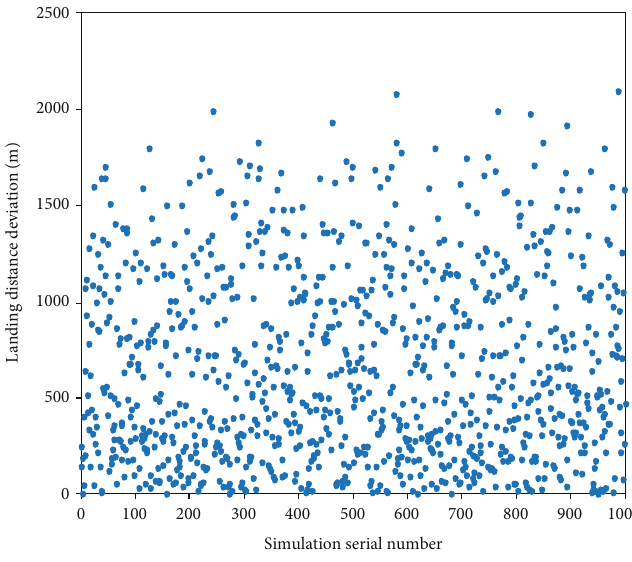
Figure 12: Deviation of landing distance.